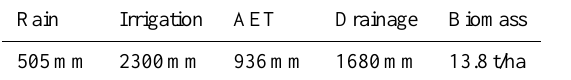
Table 4. Main terms of the water budget and biomass obtained for the reference field from 1 January 2006 to 30 September 2006 with STICS. Rain Irrigation AET Drainage Biomass